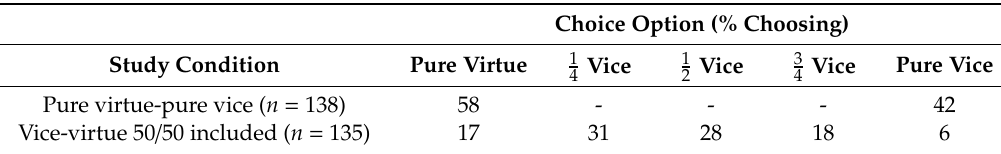
Table 3. Food choice option elected by respondents